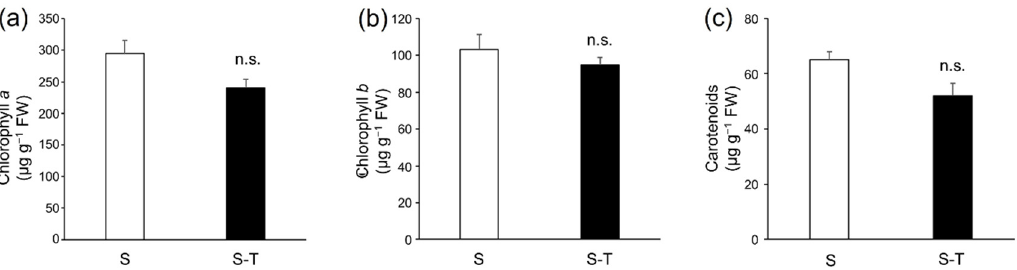
Figure 2. Concentration of ( a ) chlorophyll a , ( b ) chlorophyll b , and ( c ) carotenoids of the edible portion of Salicornia plants cultivated in monoculture (S) or in intercropping with tomato plants (S-T). Data represent the mean ± SE ( n = 4). n.s. = not significant.